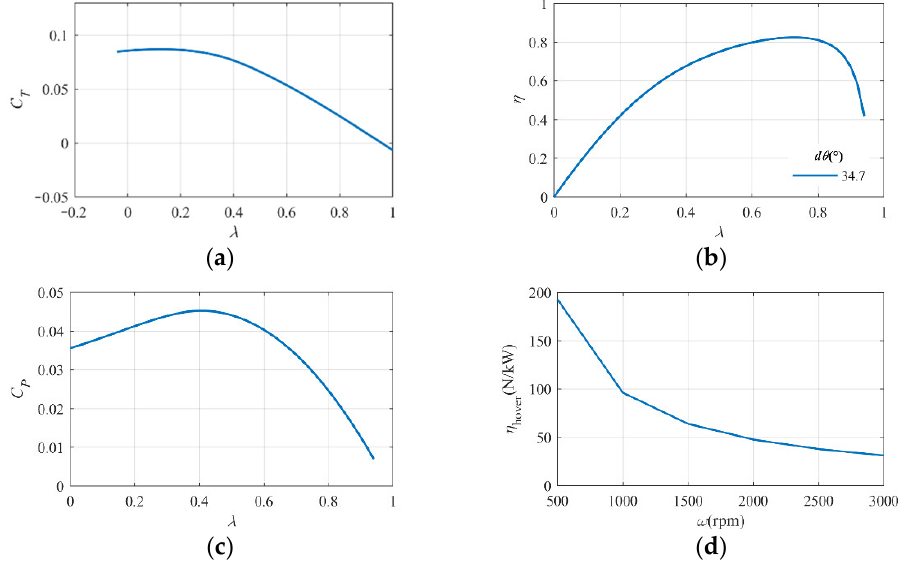
Figure 23. Performance of the selected optimal FPP. ( a ) C T ; ( b ) η ; ( c ) C P ; ( d ) η hover .